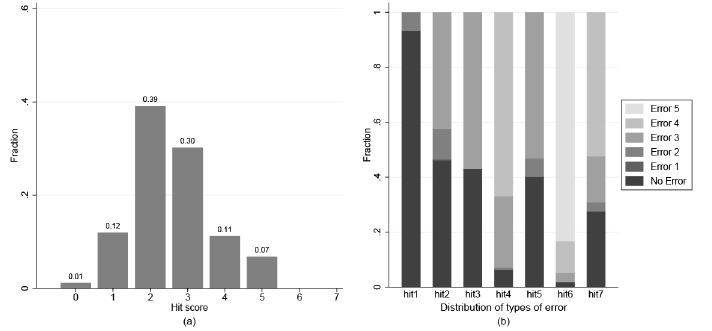
Fig 2. Subjects ’ performance in the hit